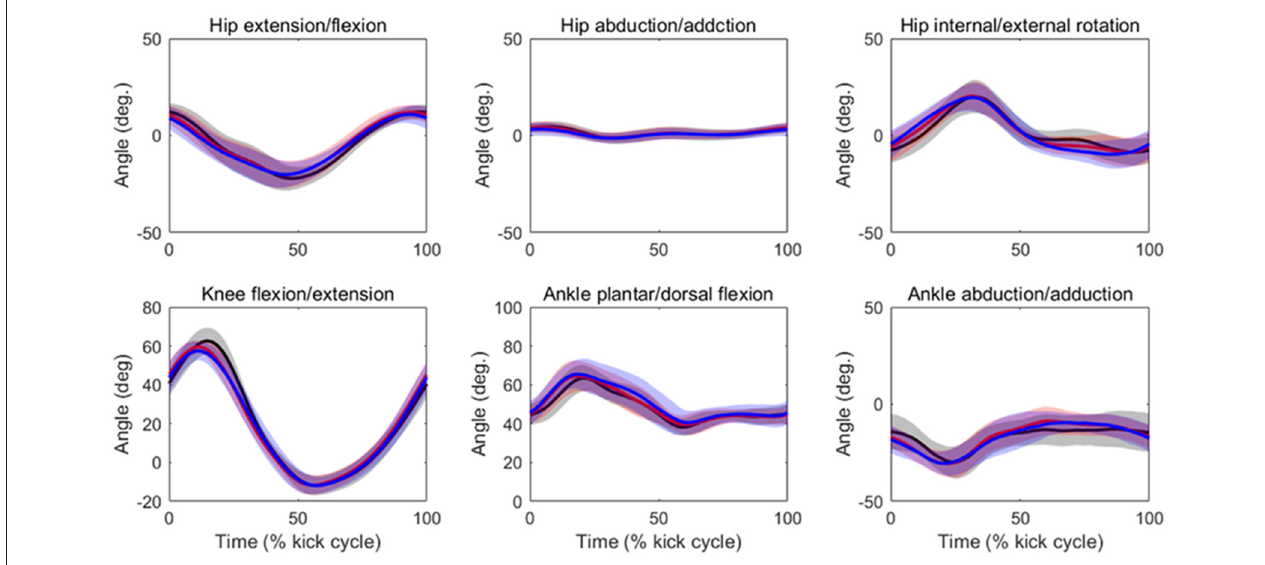
FIGURE 4 | Mean patterns and standard deviations for the hip, knee, and ankle joint angle data in the 70%V (black), 80%V (red), and 90%V (blue) trials.